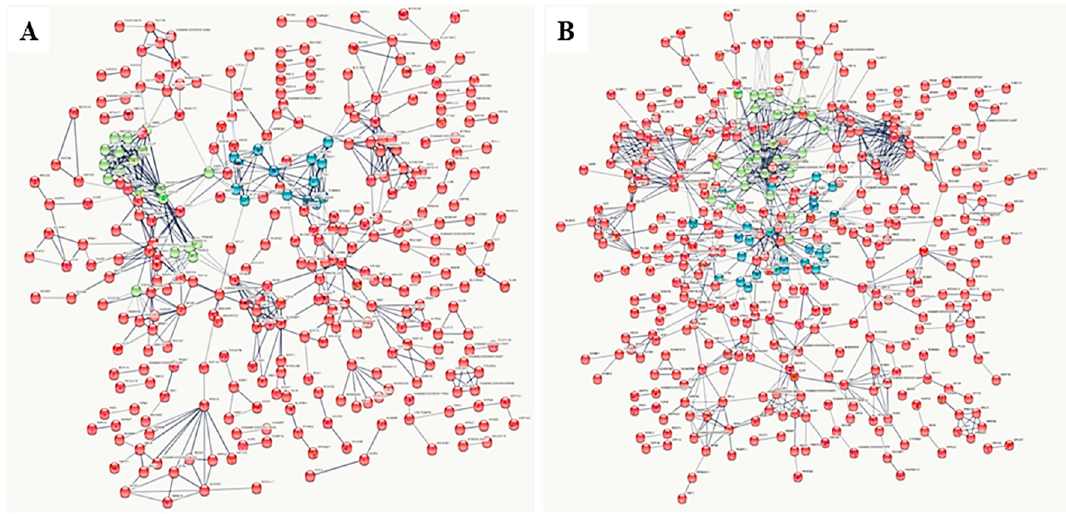
Figure 3. Protein–protein interaction (PPI) networks in dataset specifics to small non-atretic (SNA: ( A )) and large non-atretic (LNA: ( B )). The figure shows the overview dynamic pattens of PPI networks in the porcine FF during follicle growth. The LNA dataset has more interaction networks than the SNA. Kyoto Encyclopedia of Genes and Genomes (KEGG) pathways—Shared and specific proteins.